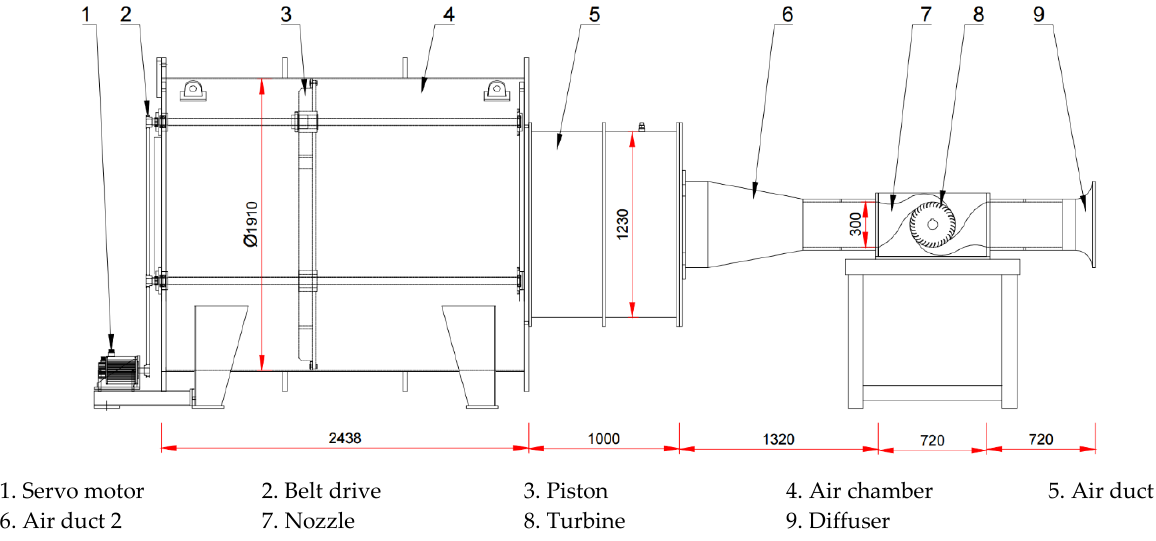
Figure 3. Layout of the wave simulator facility.